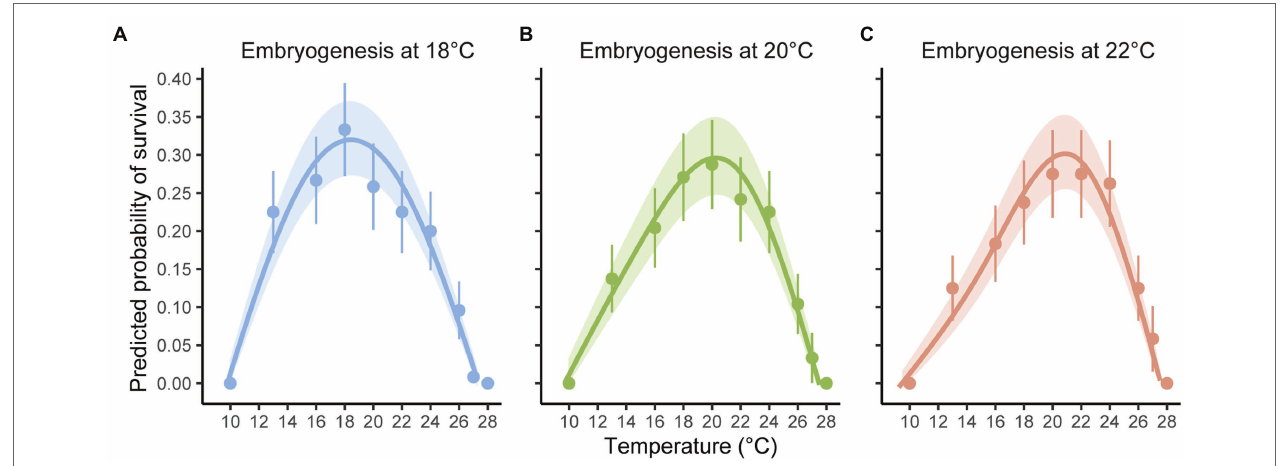
FIGURE 1 | Thermal performance curves showing the predicted probabilities of successfully surviving planktonic development after embryogenesis at (A) 18, (B) 20, and (C) 22 ° C. Points are observed success (mean and 95% CI) per temperature. Curves are predicted from a binomial mixed-effects regression of success on temperature, with shaded areas indicating 95% CIs of curve predictions. Temperature at embryogenesis was manipulated factorially with temperature at fertilization, but no effects of fertilization history on thermal performance were detected (see Table 1 ; Supplementary Figure S1